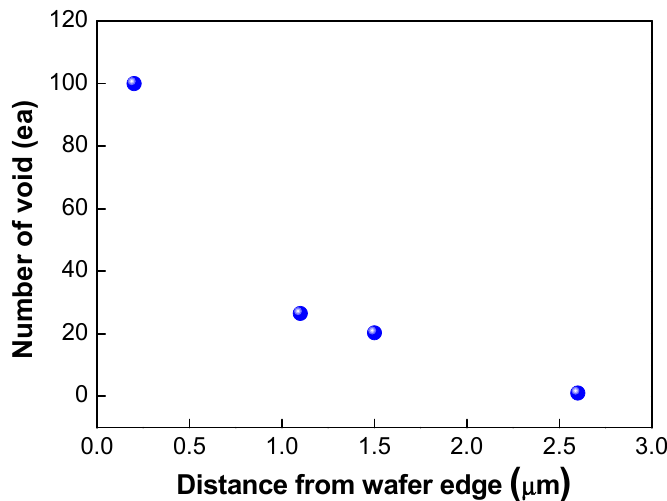
Figure 12. Number of edge voids and locations measured from the wafer edge.